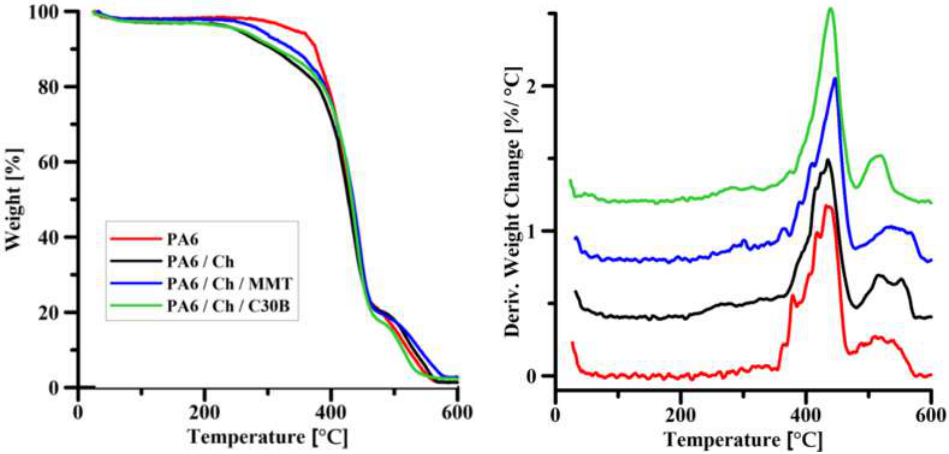
Figure 4. Thermograms of the pure PA6 membrane and composite membranes. Alongside: Corresponding derivatives of TGA curves for the same sample. Table 2. TGA data for all analyzed samples.